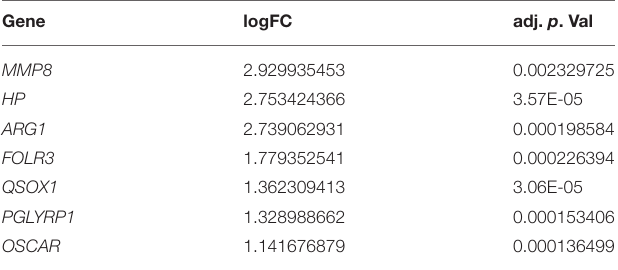
TABLE 2 | LogFC and adj. p Val of 7 hub genes in dataset